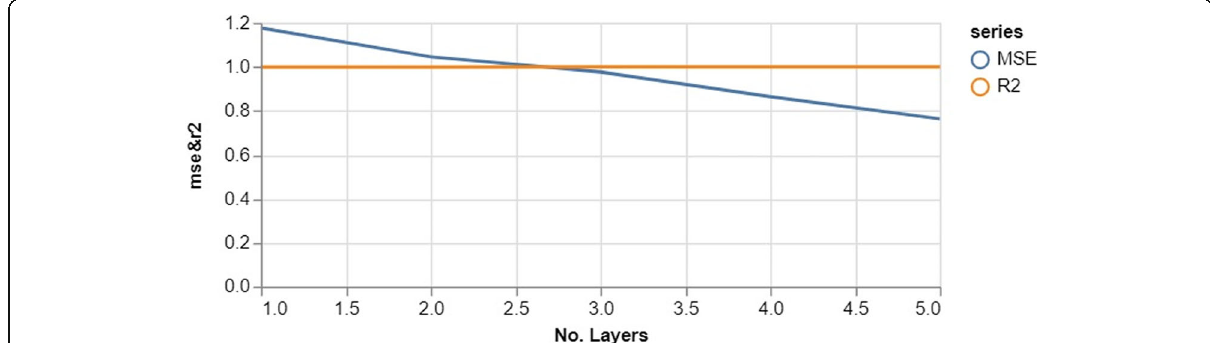
Fig. 5 A graph showing the mse and regression score for the different number of layers